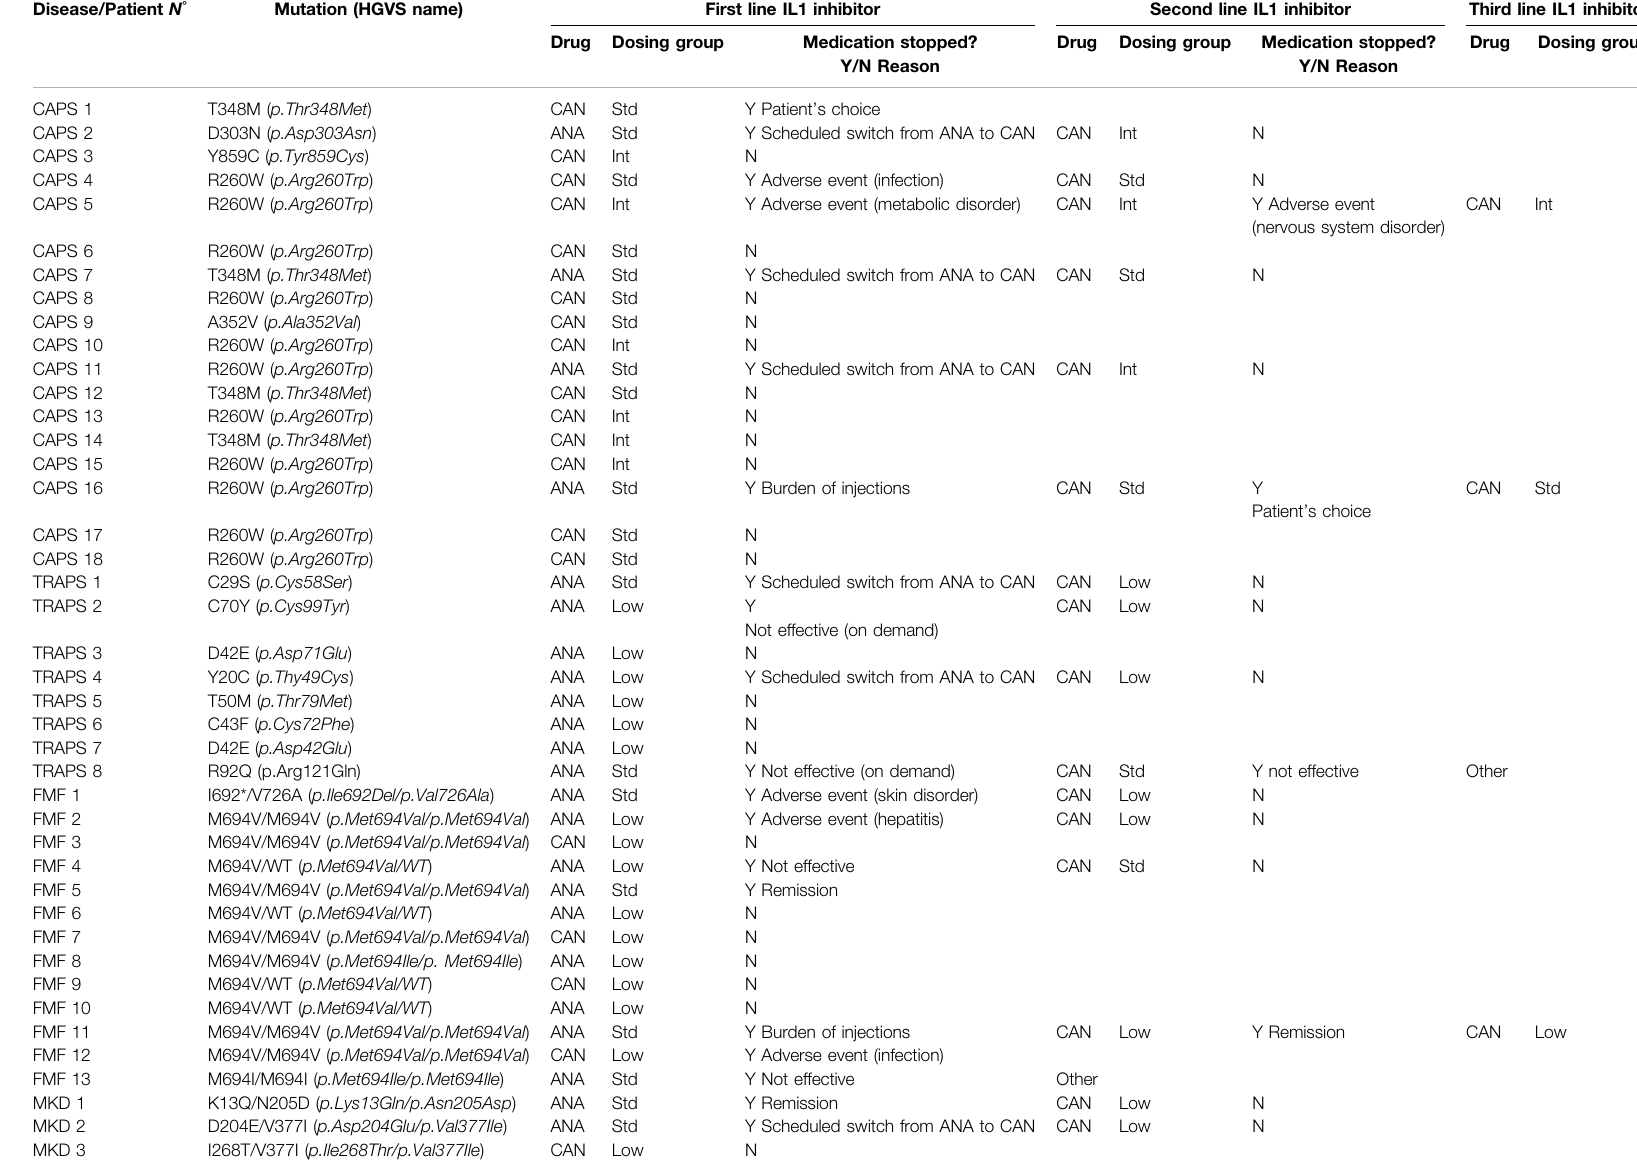
TABLE 1 | Patients characteristics and received IL1inhibitor. Disease/Patient N